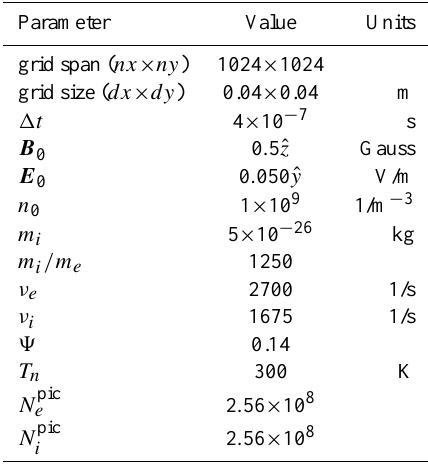
Table 1. Parameters of Baseline Simulation. Here 9 ≡ ν e ν i /(cid:127) e (cid:127) i and N pic e , N pic are the number of macro PIC particles used to model i the behavior of the n 0 n x d x n y d y particles per length. The T n is the neutral temperature. All other parameters have their typical mean-